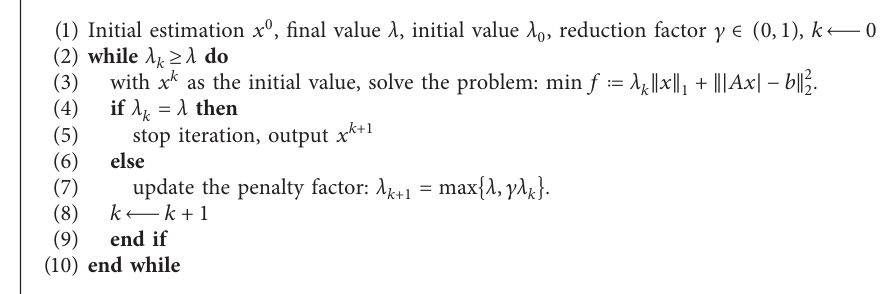
A LGORITHM 1: The general framework of the proposed